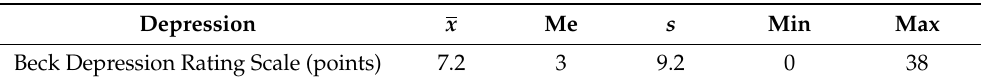
Table 5. Level of depression in the studied population.